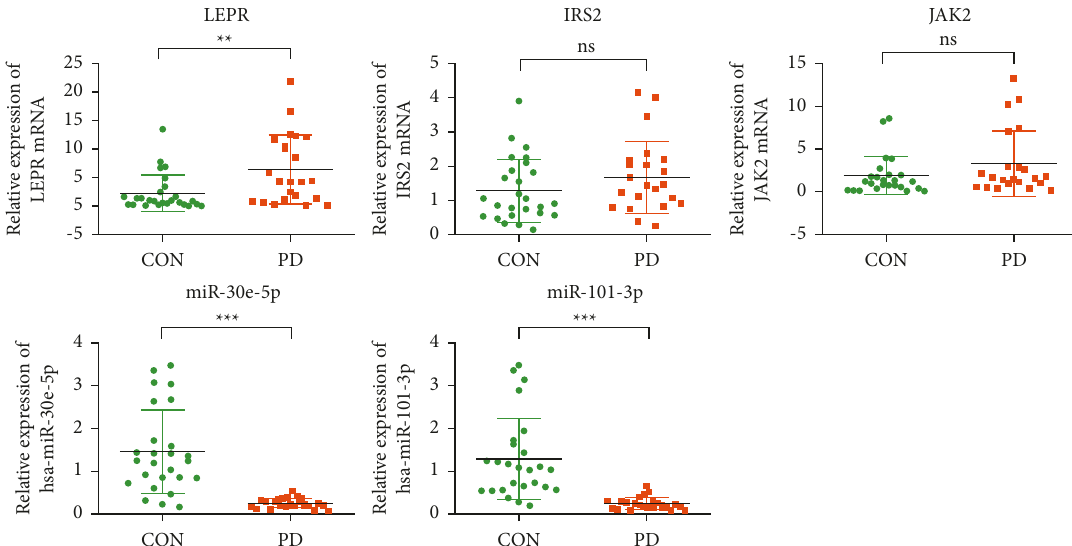
Figure 7: Evaluation of the miRNA-mRNA regulatory network in clinical PD samples. Real-time PCR was performed to examine the RNA levels of miR-30e-5p, miR-101-3p, JAK2, LEPR , and IRS2 in the peripheral blood samples of 23 PD patients and 26 healthy donors.